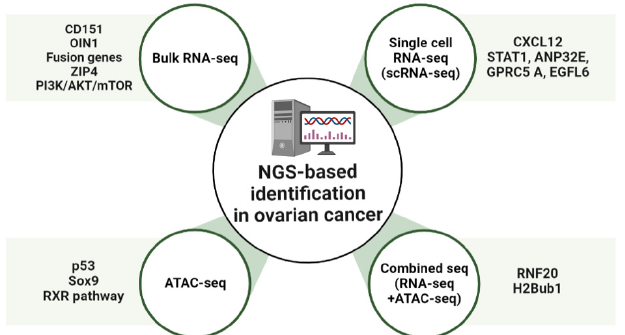
Figure 1. Overview of NGS-based identification in ovarian cancer (OC). Schematic showing molecular targets of OC treatment. OIN1, Ovarian cancer long intergenic noncoding RNA 1; CXCL12, C-X-C motif chemokine 12; ANP32E, Acidic Nuclear Phosphoprotein 32 Family Member E; GPRC5A, G-protein coupled receptor family C group 5 member A; EGFL6, Epidermal growth factor-like domain-containing protein 6; RXR, Retinoid X receptor; RNF20, Ring finger protein 20.